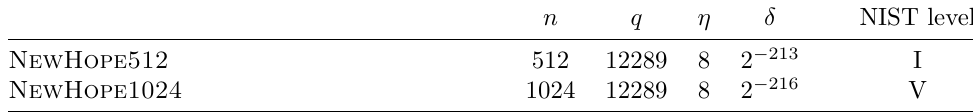
Table 1: NewHope parameter sets (see [AAB + 19]). The failure probability is given as δ .